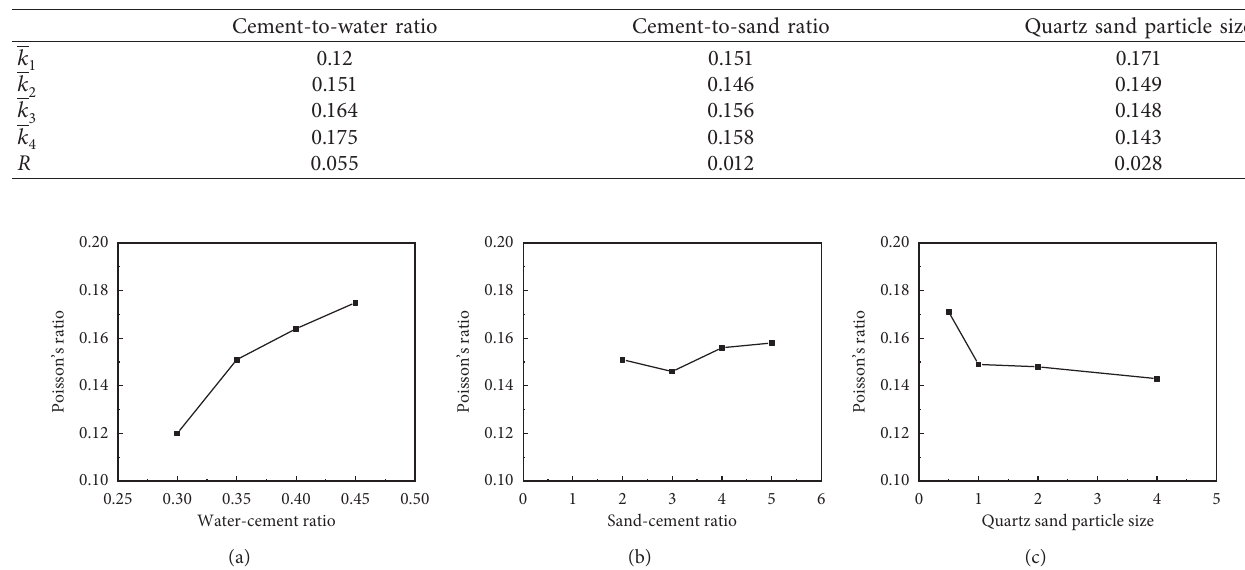
Table 7: Range analysis of Poisson’s ratio.